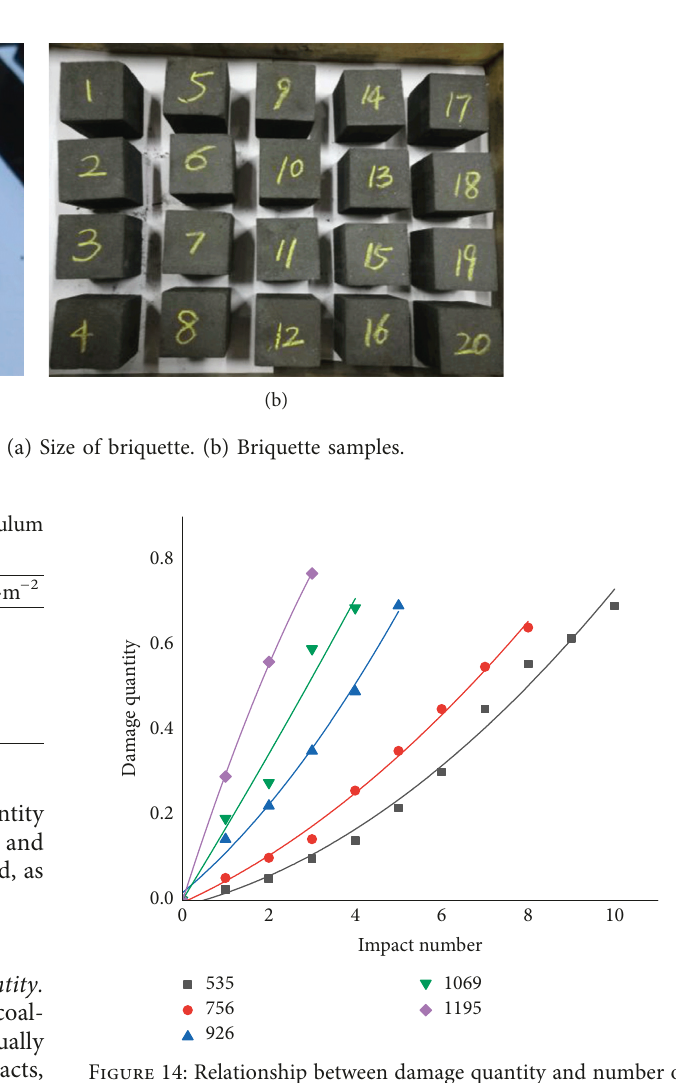
Figure 14: Relationship between damage quantity and number of impulse cyclic impact of different